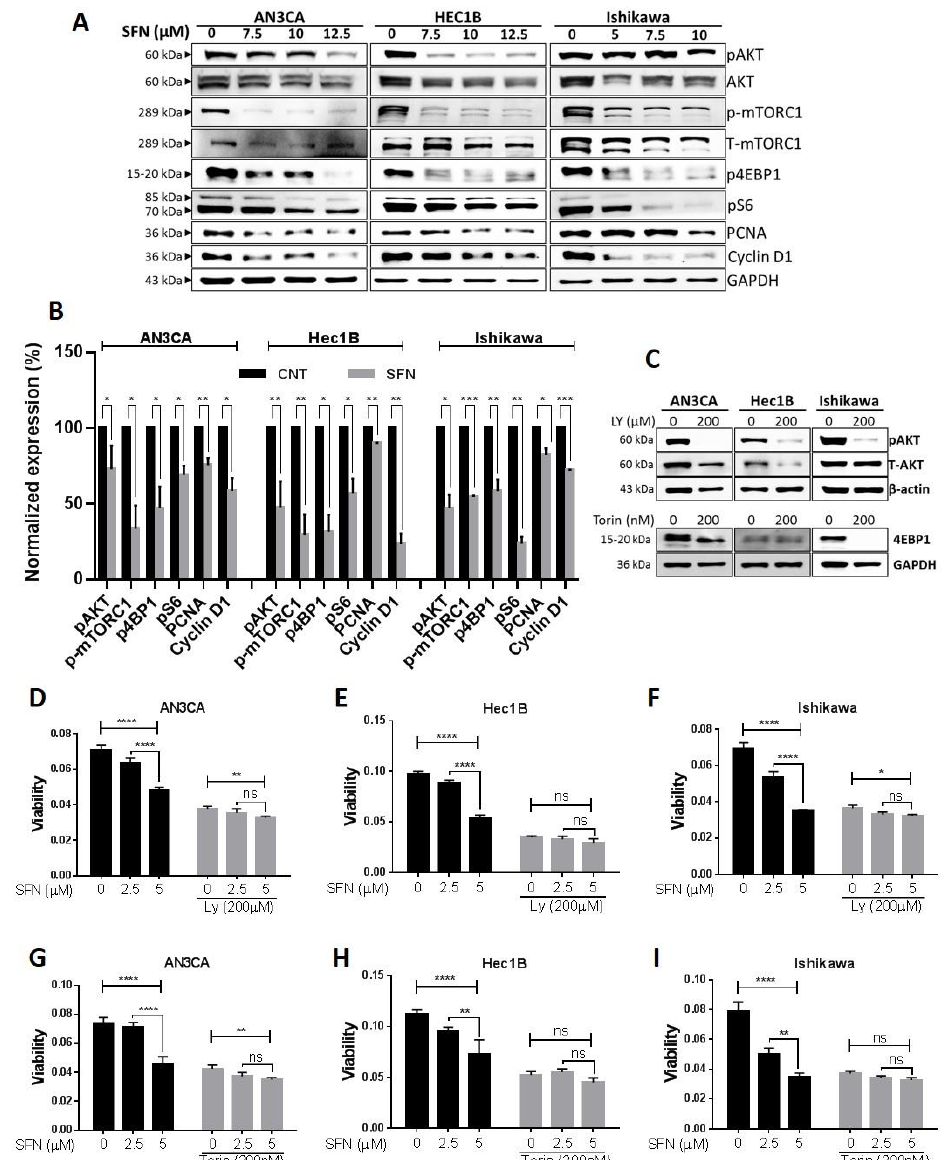
Figure 4. Sulforaphane inhibits endometrial cancer cell proliferation via inhibition of the PI3K-AKT-mTOR pathway. ( A , B ) Endometrial cancer cells were treated with the indicated concentrations of sulforaphane for 24 h, and protein isolated were analyzed for expression of PI3K-AKT-mTOR signaling markers by western blot. GAPDH was used as a loading control. Representative blots are shown ( A ) and densitometric quantitation of protein expression levels in control (vehicle treated) vs. sulforaphane treated endometrial cancer cells (12.5 µM of sulforaphane for AN3CA and Hec1B and 10 µM of sulforaphane for Ishikawa) are shown as fold changes with ± SE and t -test was used for statistical analysis ( B , C ) Endometrial cancer cells were treated with PI3K inhibitor (LY) and mTOR inhibitor (Torin) at indicated concentration for 4 h. Protein isolates were analyzed by western blot analysis to confirm the knockdown of PI3K downstream e ff ector phosphorylation of AKT Ser473 and mTOR downstream e ff ector phosphorylation of 4EBP1Thr 37 / 46 . GAPDH was used as a control to correct for loading. Representative blots are shown. ( D – I ) Endometrial cancer cells were pretreated with LY ( D – F ) or Torin ( G – I ) or vehicle for 4 h prior to addition of sulforaphane for 24 h, and cell viability was analyzed by MTT. Cell viability (optical density) are shown as mean ± SD and Two-way ANOVA was used for statistical analysis. ‘ p ’ values are indicated * p ≤ 0.05, ** p ≤ 0.01, *** p ≤ 0.001, **** p ≤ 0.0001 when compared with respective control. SFN; sulforaphane. The whole western blot images of Figures please find in Figure